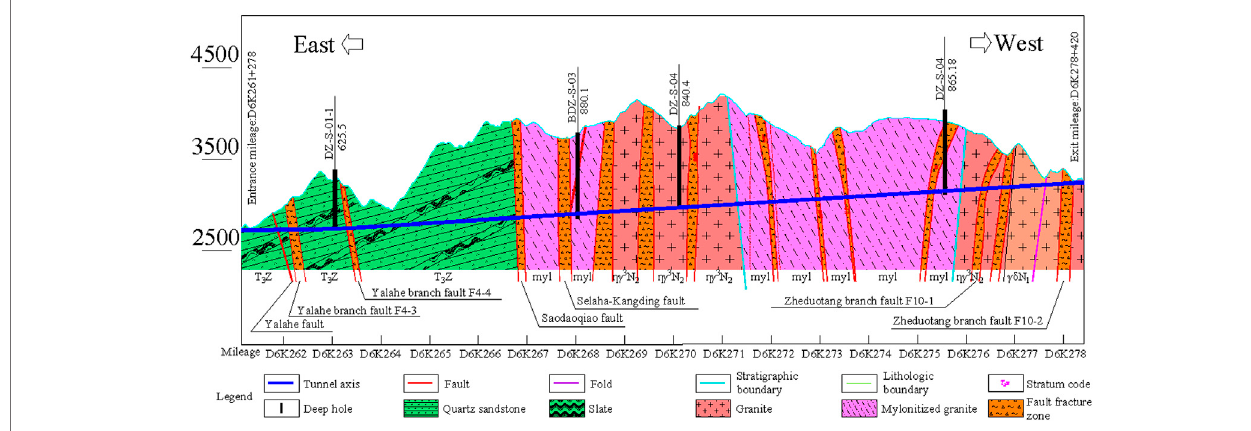
FIGURE 2 | Geological section of the tunnel site.